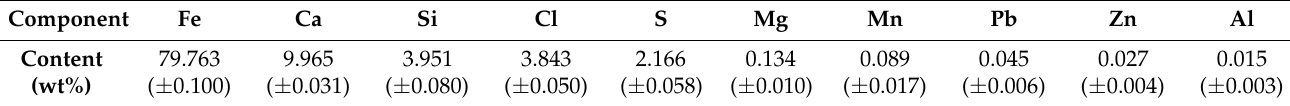
Table 3. The chemical composition of the blast furnace dust.